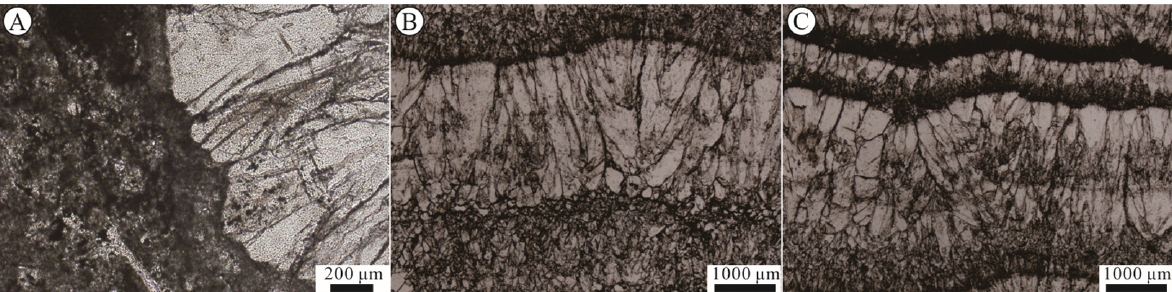
Figure 3. Thin-section microphotographs of the Sobcha travertines ( A – C ); plane-polarized light. ( A ) Clotted peloidal boundstone and fan crystals. ( B ) Fan crystals and granular crystals. ( C ) Fan crystals.